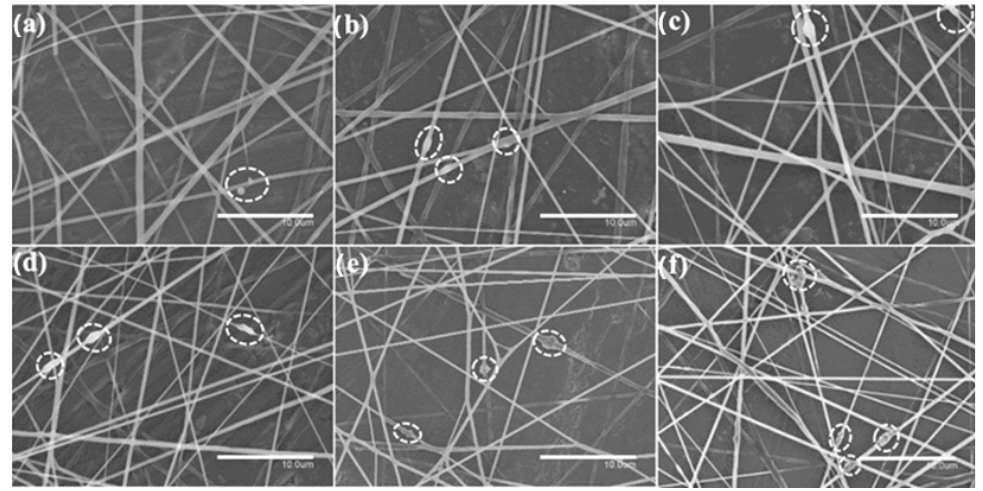
Figure 2. Comparison of the morphology of the electrospun poly(3-hydroxybutyrate-co-3-hydroxyvalerate) (PHBV) fibers: ( a ) 0.5 wt.% CeO 2 NPs; ( b ) 1.0 wt.% CeO 2 NPs; ( c ) 1.5 wt.% CeO 2 NPs; ( d ) 2.0 wt.% CeO 2 NPs; ( e ) 5.0 wt.% CeO 2 NPs; ( f ) 10.0 wt.% CeO 2 NPs. Micrographs were taken by scanning electron microscopy (SEM). Scale bar corresponds to 10 µm. Dotted circles highlight the presence of beads and aggregates within the fibers.